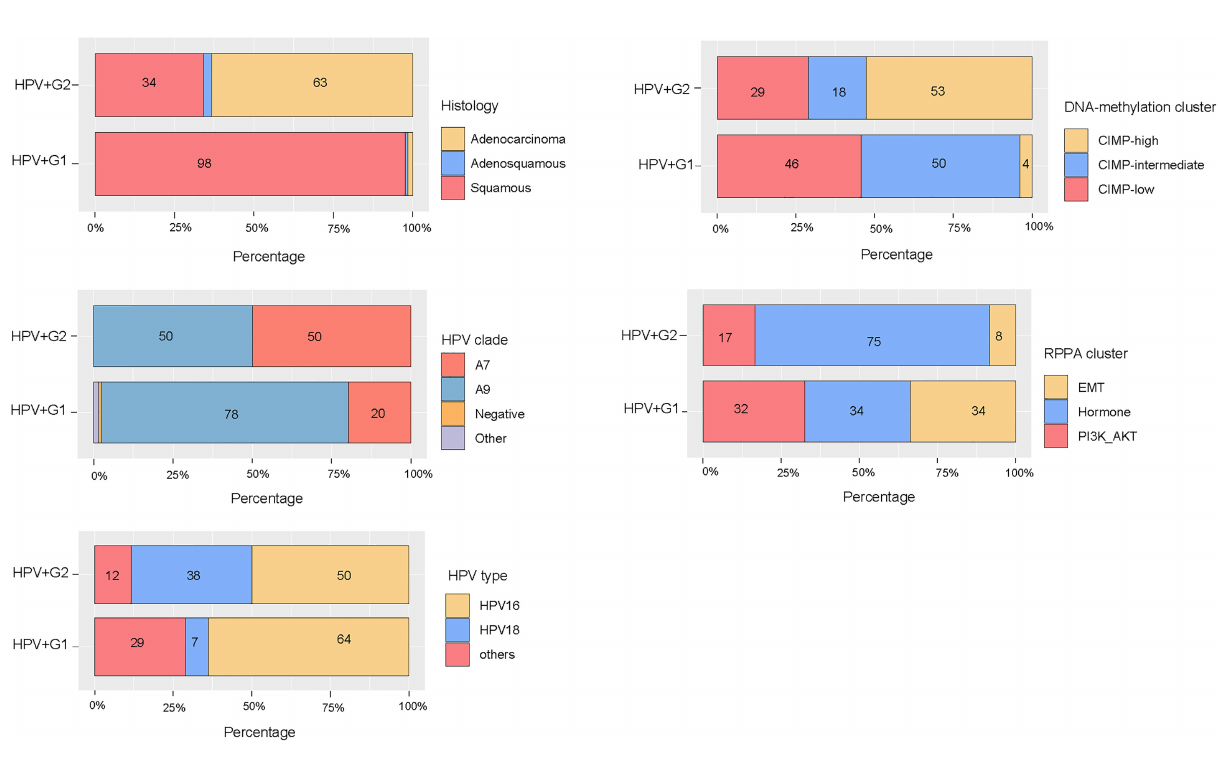
FIGURE 6 | Overlapping between the HPV+ subtypes and other subtypes of cervical